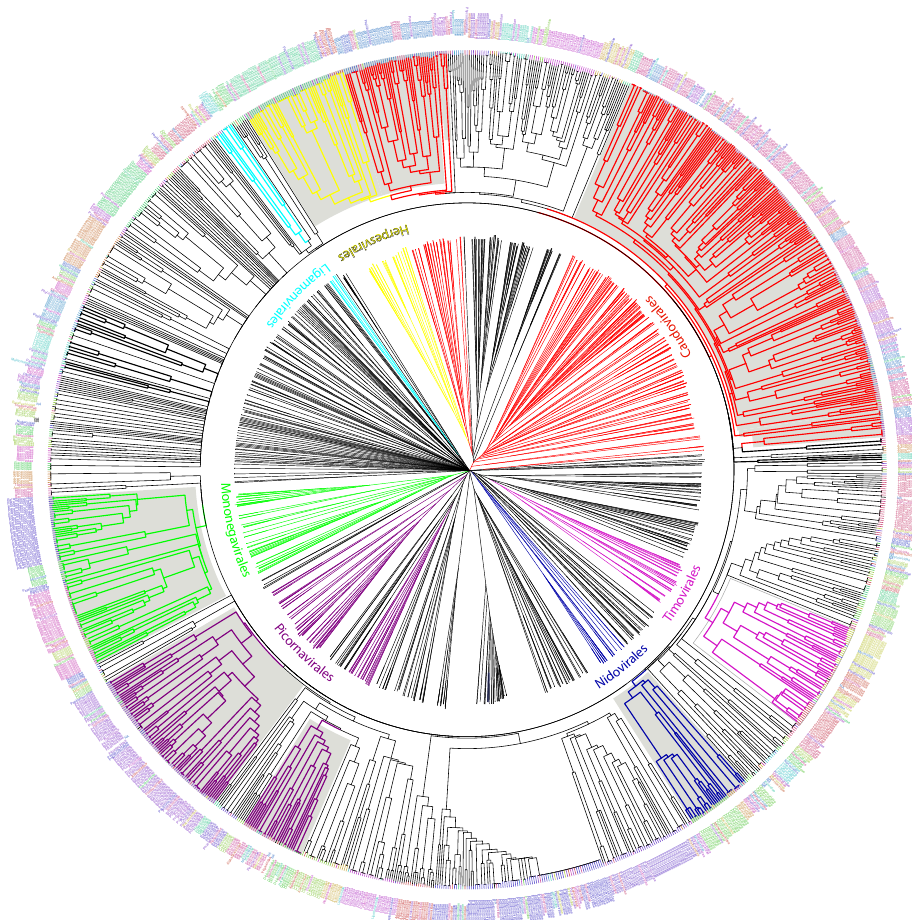
Figure 5. UPGMA tree representation of the non-redundant viral diversity. Unrooted (center) and circular middle point rooted (outer circle) representations of an UPGMA tree of the non-redundant viral diversity, based on the presence or absence of informative ViPhOGs. Colored branches highlight ICTV designated Orders. Bold black branches highlight phage families without an order assignment. Names between the trees indicate the name of the ICTV taxonomic order colored in the same color for the branches. Tip labels indicate the family of each genome and are colored to facilitate their differentiation within an order not to provide a different color to each